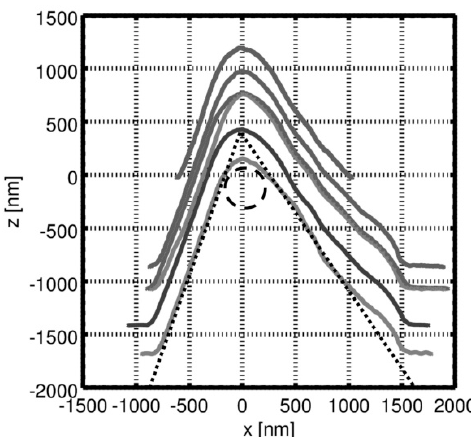
Figure 16. Tip shape reconstruction by matching the two previously extracted profile halves. Cone angle and diameter estimation: dashed line.